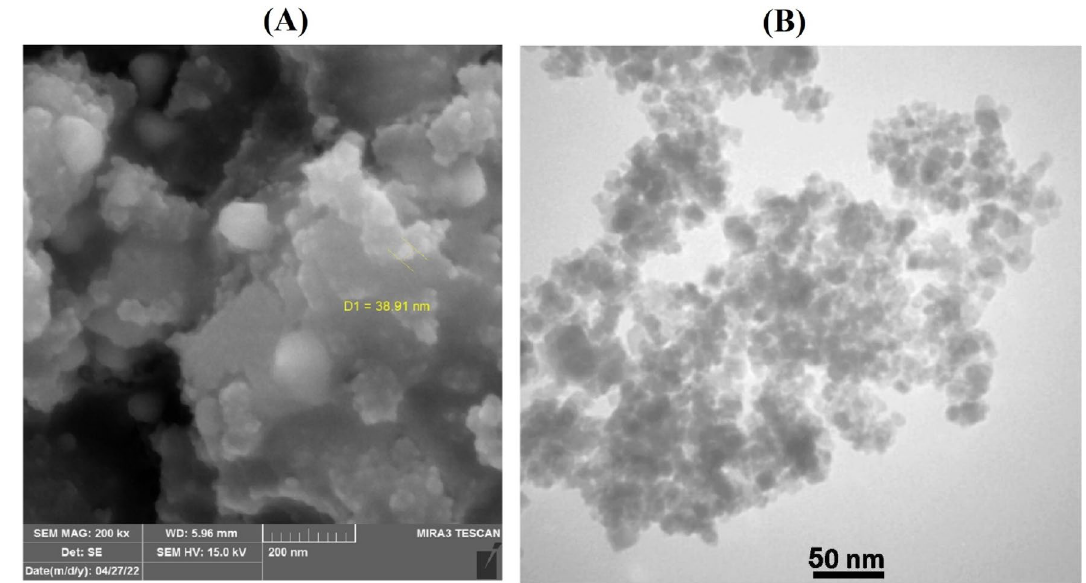
Figure 14. ( A ) SEM and ( B ) TEM images of recovered Fe 3 O 4